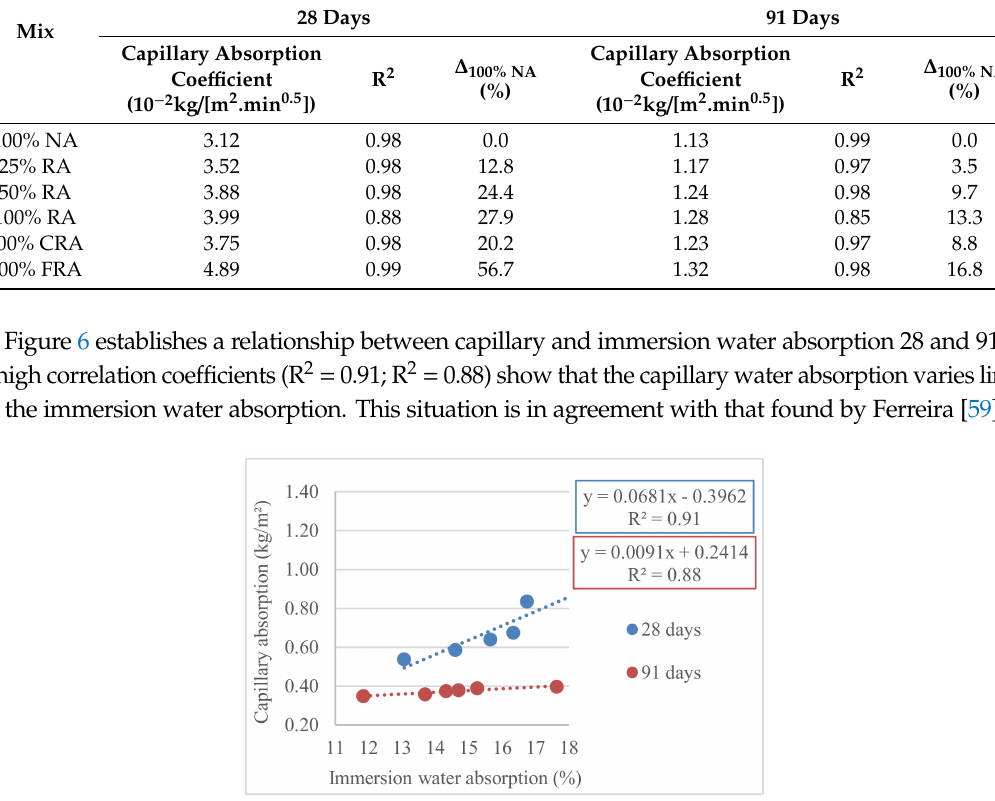
Figure 6. Relationship between immersion water absorption and capillary water absorption results at 28 and 91